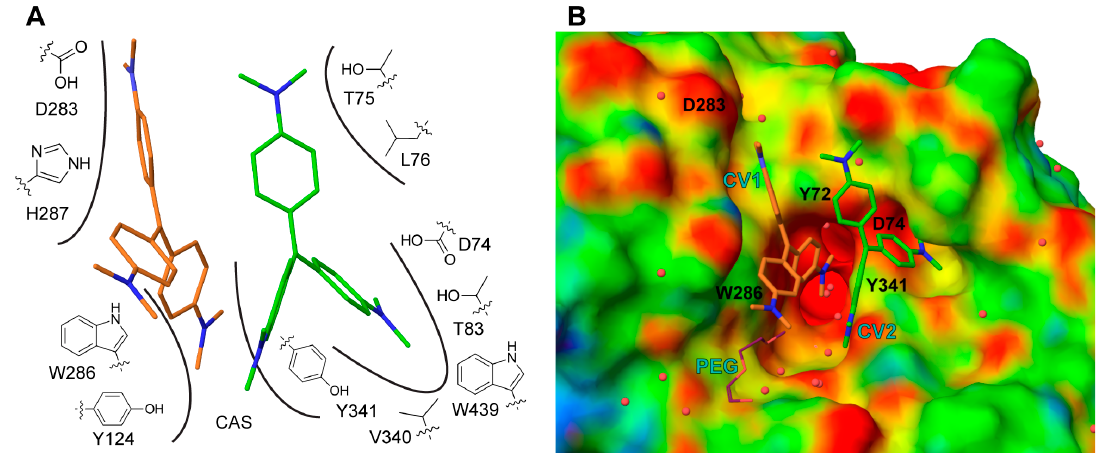
Figure 4. Schematic ( A ) of the interactions between CV1 (orange), CV2 (green) and m AChE, where interacting amino acids are indicated with number and is the catalytic site (CAS). m AChE electrostatic potential surface ( B ) with low, medium and high potential coloured in red, green and blues, respectively. The positions of mutated amino acids are indicated with residue name and number. For clarity, the polyethylene glycol (PEG) molecule is omitted in A.